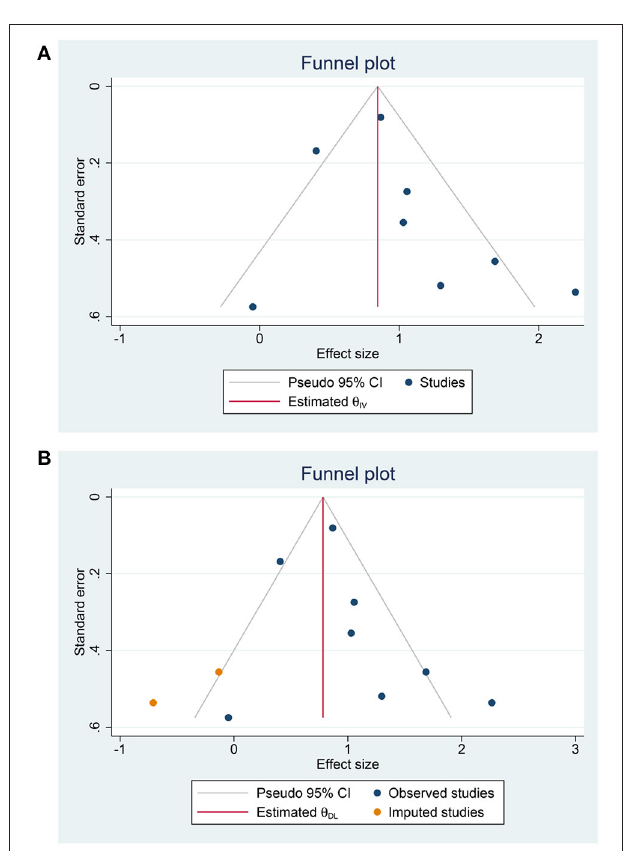
FIGURE 3 | Publication bias. Funnel-plot analysis (A) and trim-and-fill analysis (B) .